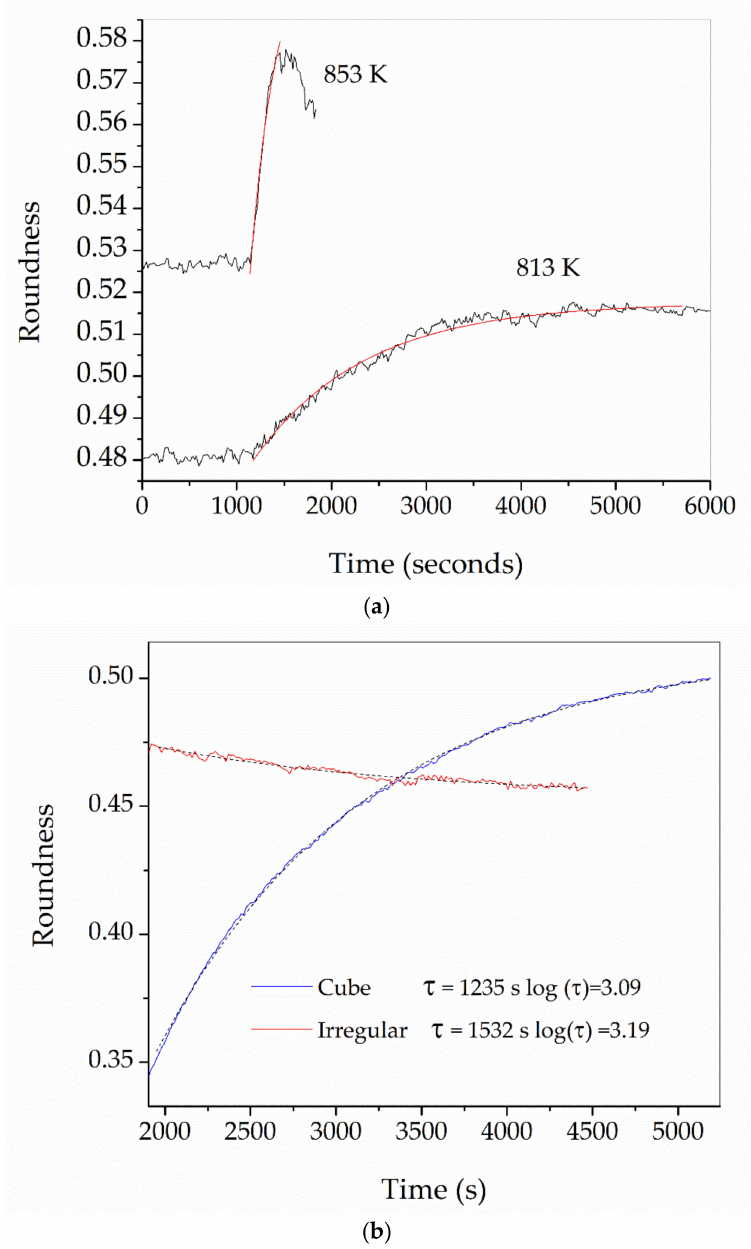
Figure 5. ( a ) Roundness vs. time, measured on two irregular SiTiFD glass samples, as shown in Figures 3 and 4. The sample heated at 813 K exhibits a slight viscous flow, increasing its roundness. The sample heated at 853 K has faster kinetics and after a few minutes reaches its almost spherical shape. In red solid lines: fittings to both measured curves. Characteristic times τ obtained from both curves by fitting Equation (5) are: Log( τ ) at 813 K = 3.08 ( τ in s), log( τ ) at 853 K = 2.43 ( τ in s). ( b ) Comparison of relaxation times measured on WG samples at 1023 K using cube geometry (blue line) and irregular geometry (red line). The dashed black lines are Equation (5)